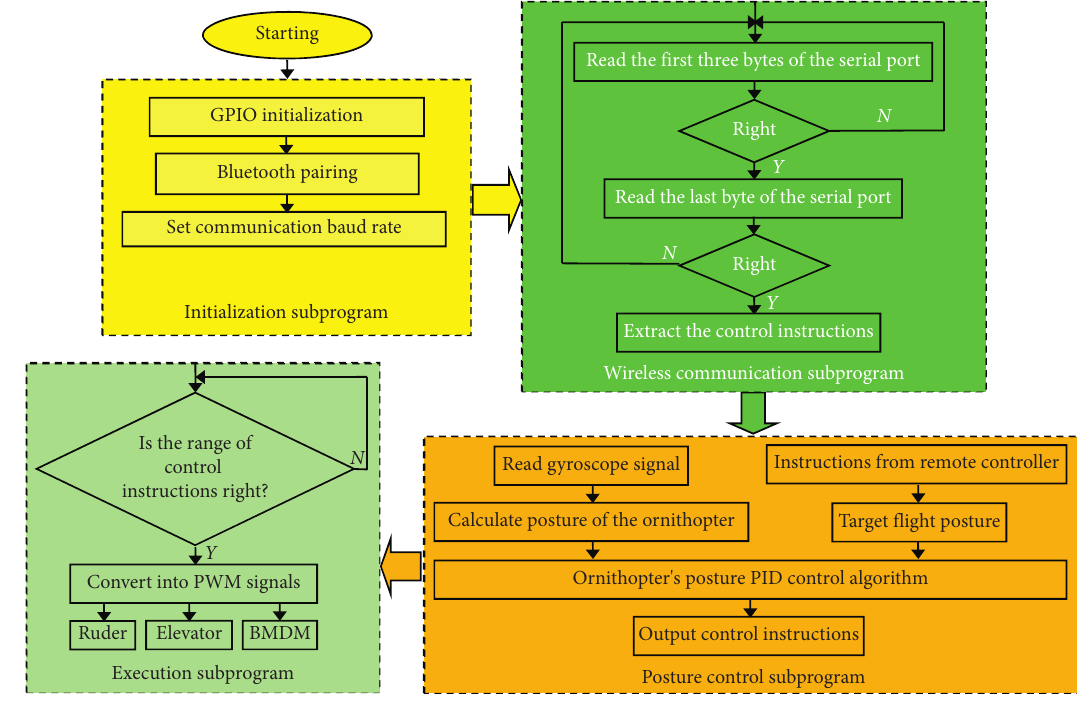
Figure 13: The ornithopter control block